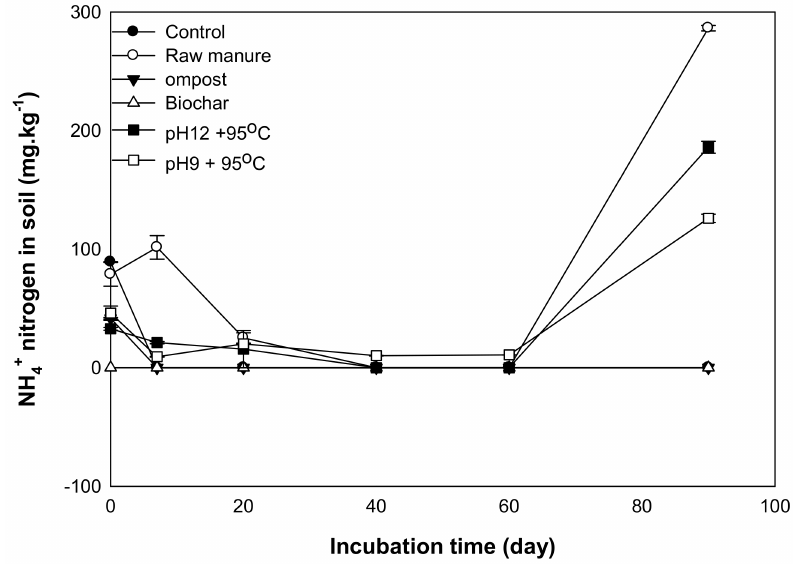
Figure 9. Available NH 4+ mg kg − 1 affected by different organic amendments derived from cow manure at different incubation